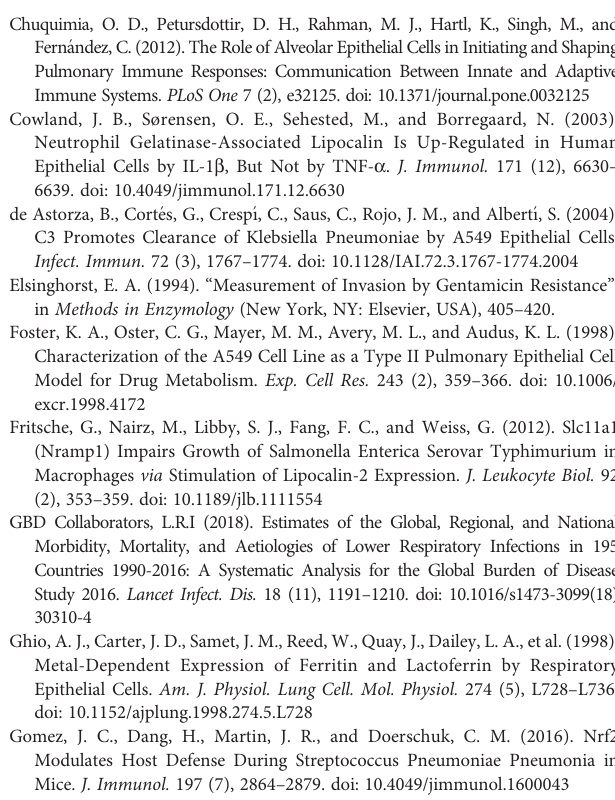
Supplementary Figure 6 | Differential mRNA expression of FPN in cells treated with heat-killed bacteria. A549 cells were treated with heat-killed (HK) E. coli or K. pneumoniae at MOI of 100 for 2h, subsequently washed thoroughly and harvested after 3h (A) and 6h (B) . Data (n=3) shown as mean ± SEM, normalized to untreated controls. HK, heat-killed; K. pneu ., K. pneumoniae ; FPN ,